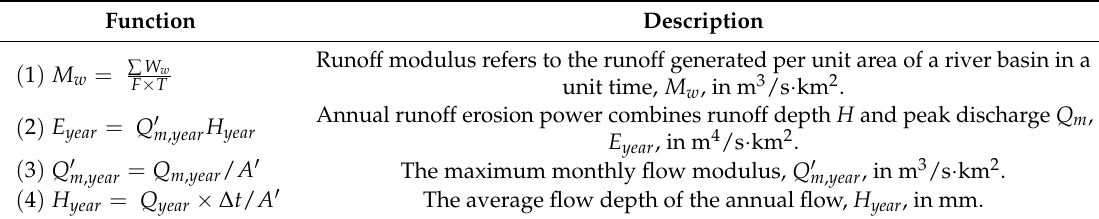
Table 2. Runoff erosion ability objective functions: W w stands for total runoff (m³), F stands for runoff area (m²), T stands for rainfall duration (s). Q m, year and Q year stand for the maximum monthly flow (m³/s) and the average annual flow (m³/s), respectively; A’ stands for the control area of the river basin, Δt stands for the period of time, calculated with an average 30 days per month, Δt = 2592 × 10³ s.